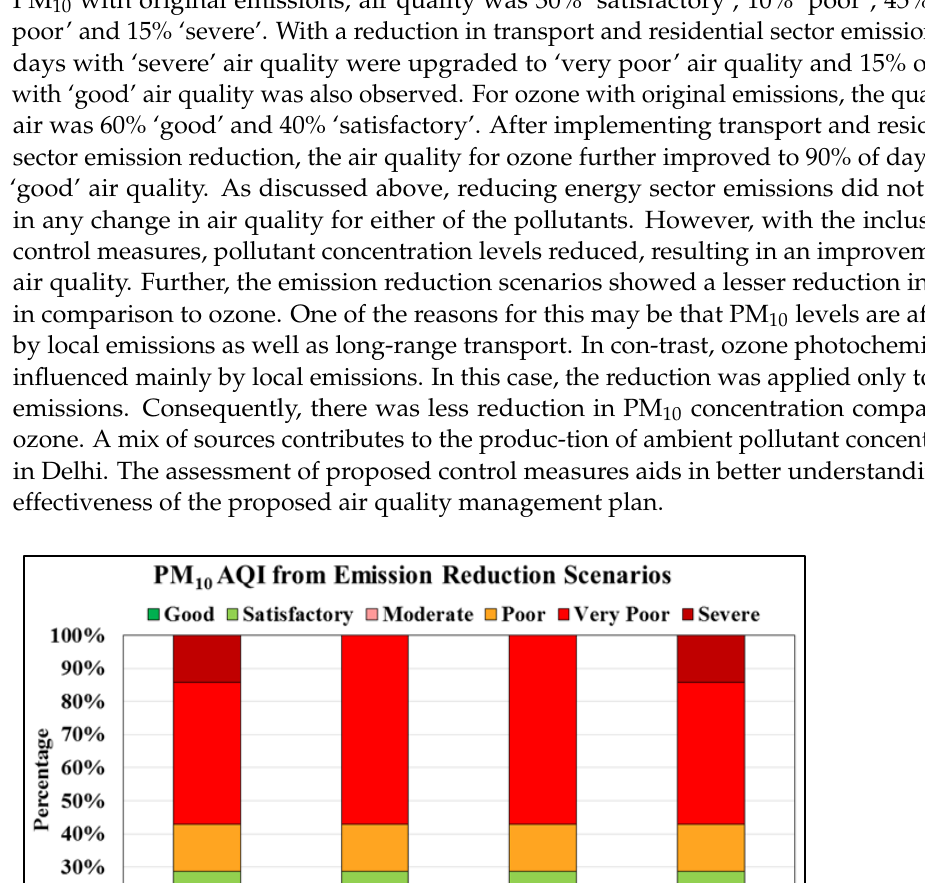
Figure 8. Air quality index of PM 10 for original and proposed emission scenarios.